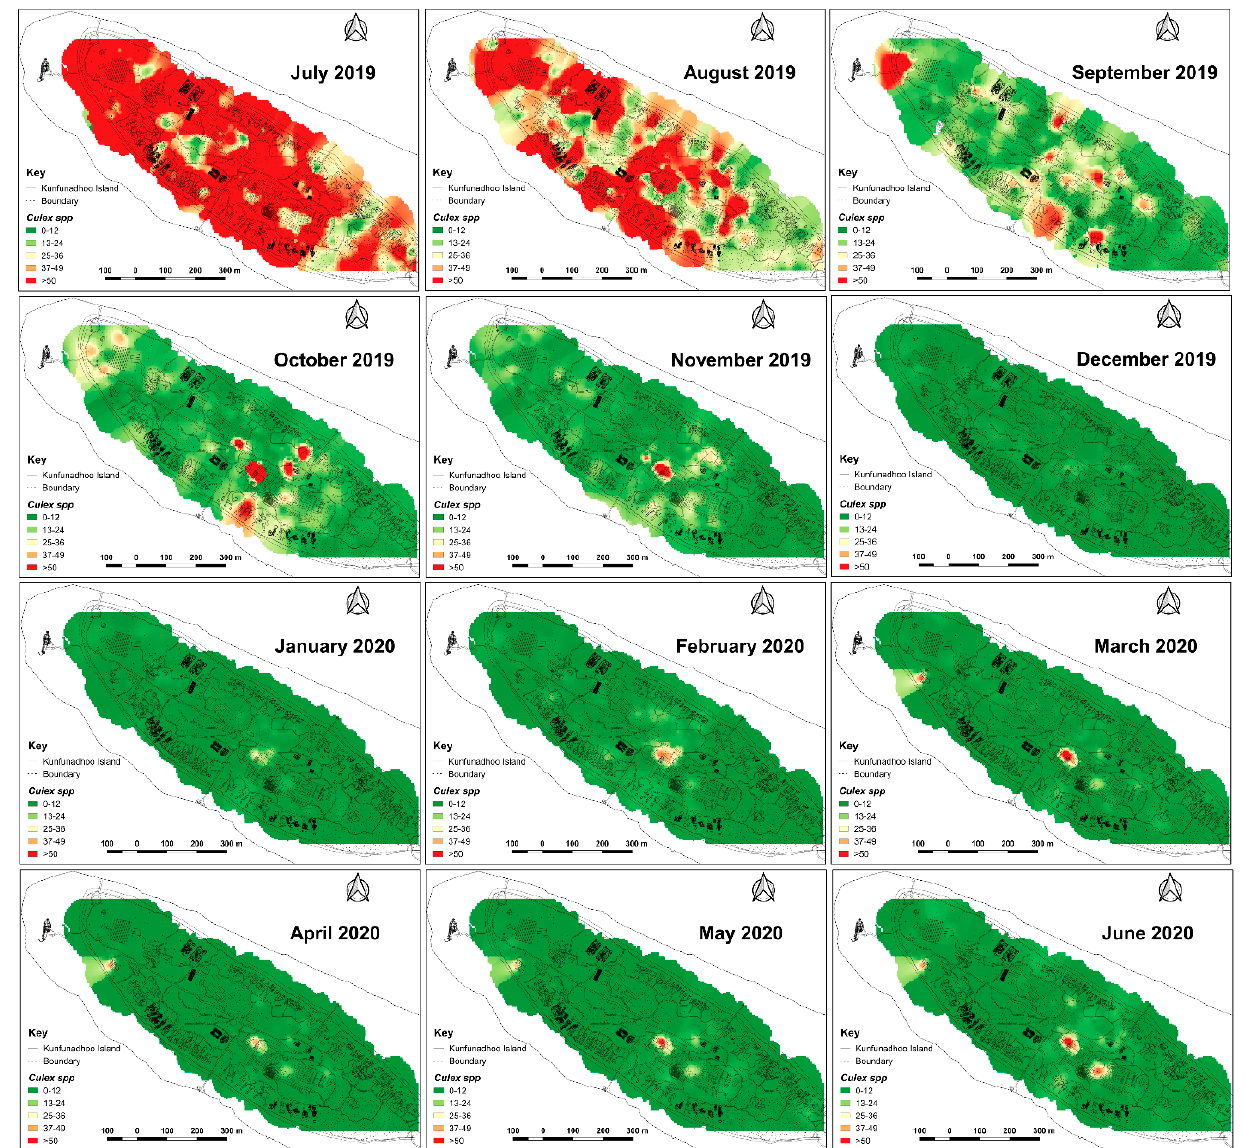
Figure 8. Inverse distance weighted heatmaps of Culex quinquefasciatus showing areas with high (red) or low (green) mosquito catches by month for the period June 2019–June 2020. Impact of trapping was observed faster than for Ae. albopictus (Figure 7) since Culex eggs cannot survive a period of drought.